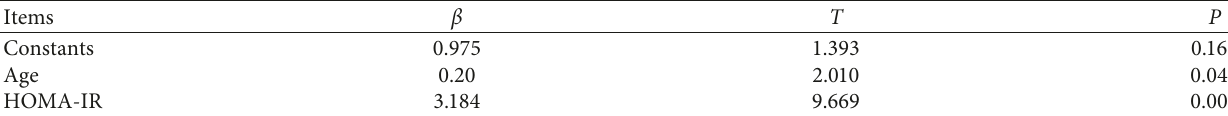
Table 5: Multiple linear stepwise regression with UACR as the dependent